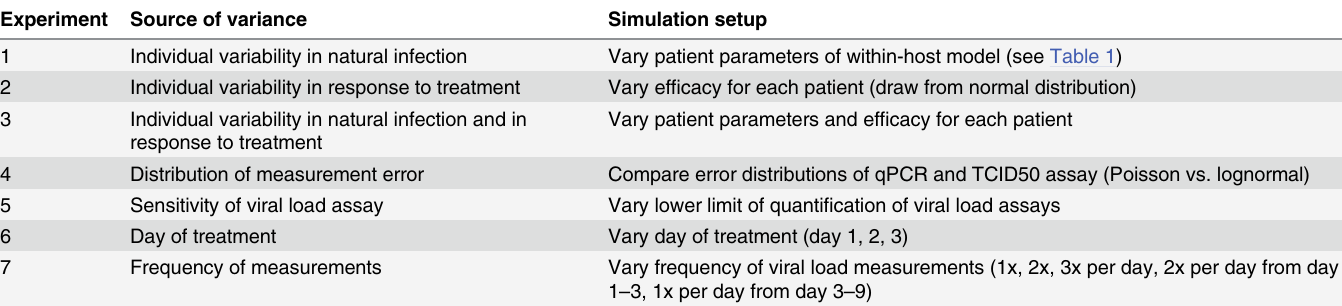
Table 3. Summary of experiments to investigate different sources of variance in clinical trials of novel treatments for influenza